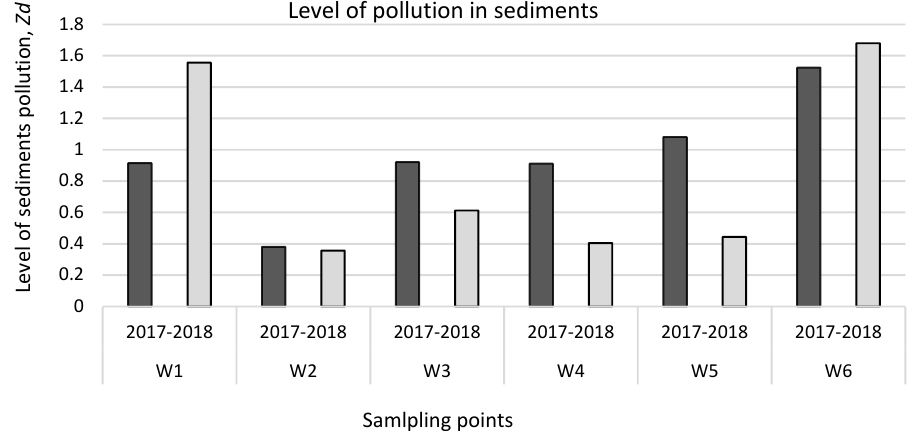
Figure 6. The level of pollution in sediments of river and ditch in 2017 and 2018 (W1, W2...W6— sampling points).